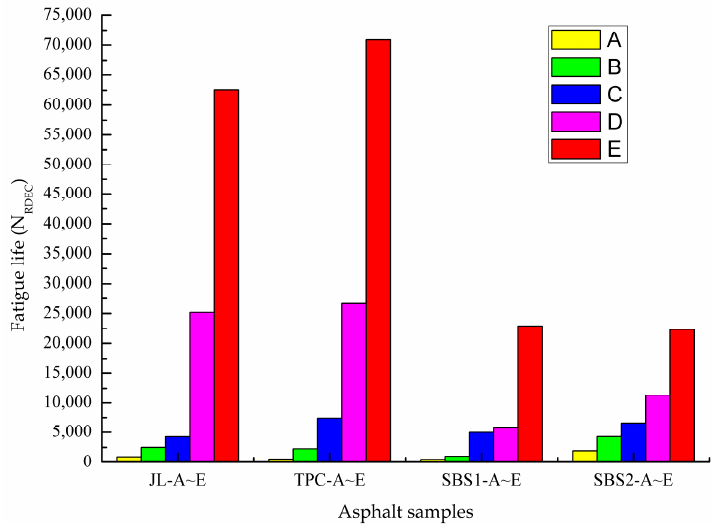
Figure 11. The fatigue life ( N RDEC ) of all asphalt samples.